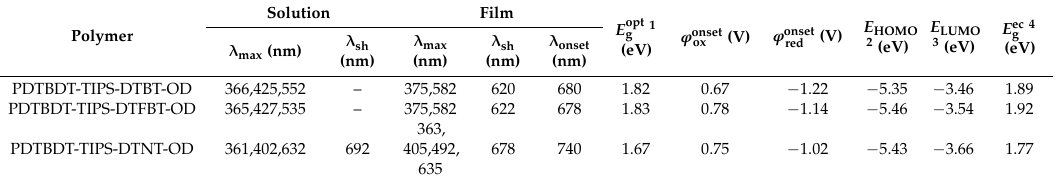
Table 1. Optical and electrochemical characteristics of copolymers.